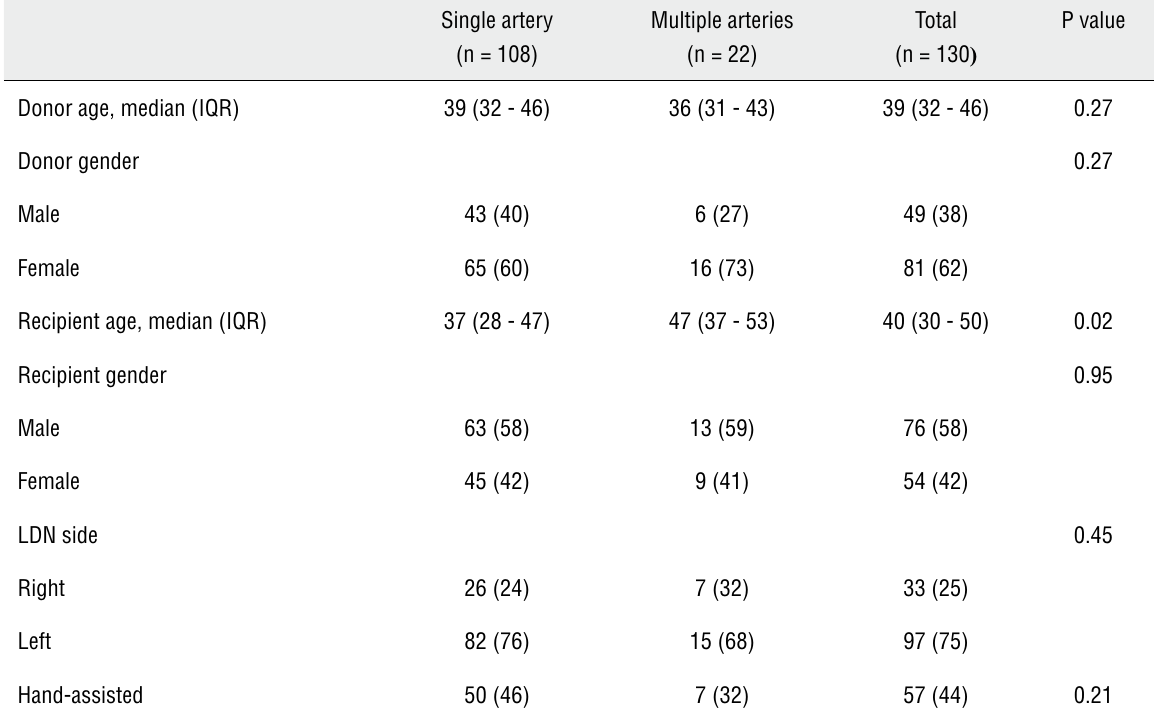
Table 1 - Patient demographics divided by number of arteries.